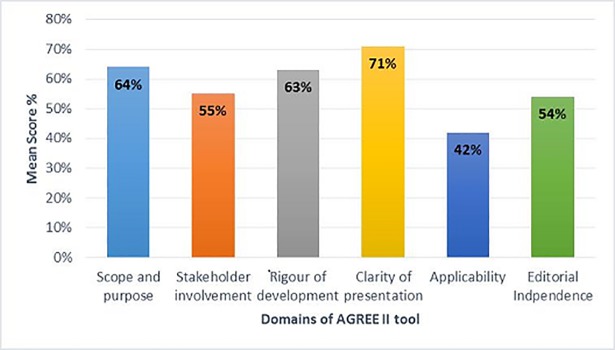
AGREE II mean standardised score for each domain for CPGs (2002–2016).